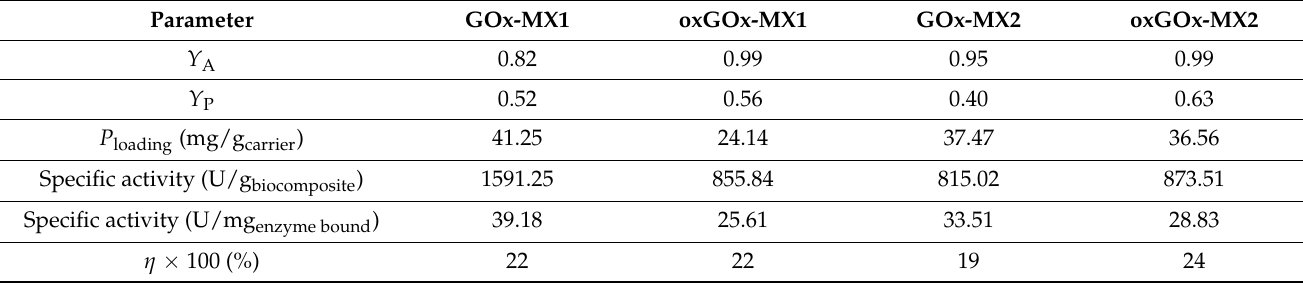
Table 2. Key immobilization performance parameters for four types of biocomposites, washed only with water.